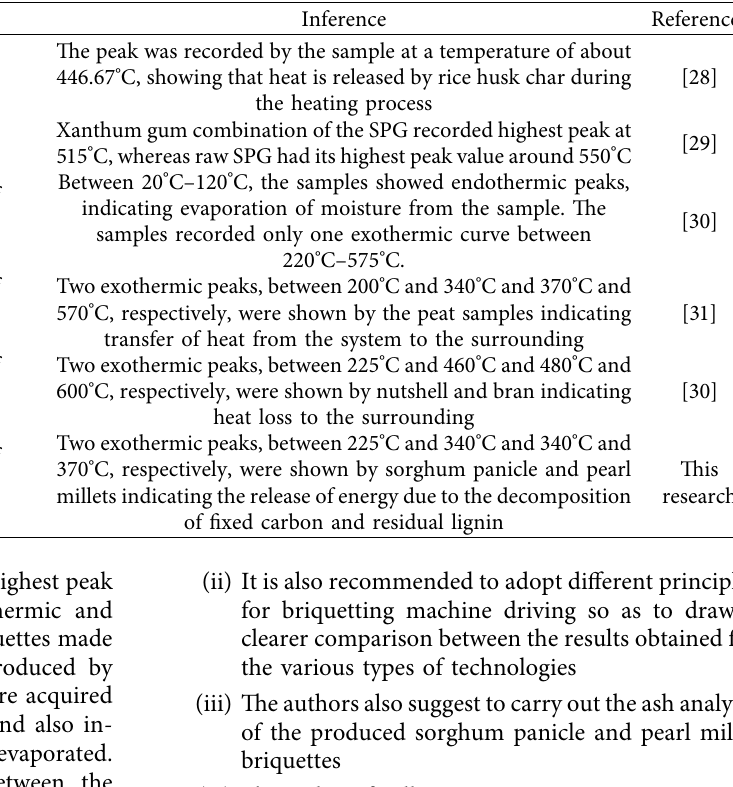
Table 3: Comparative study on differential scanning calorimetric analysis of biomass